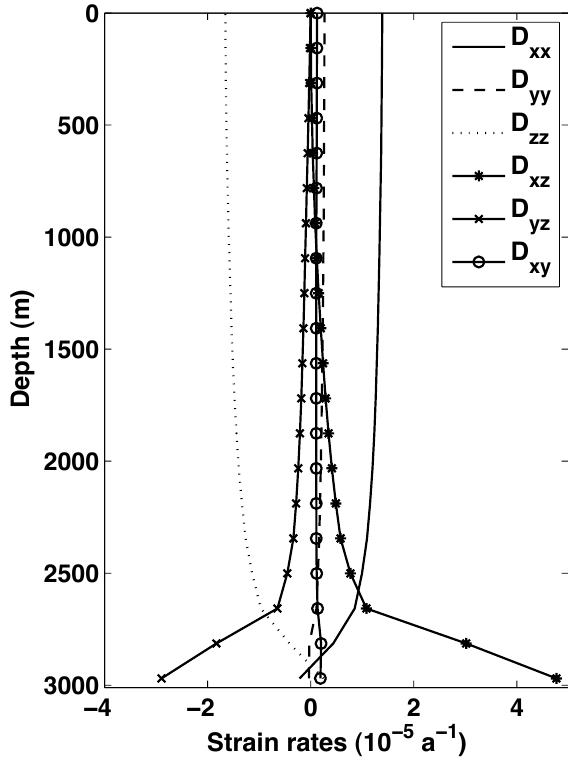
Fig. 7. Anisotropic steady-state simulation: Profiles of the compo- nents D xx , D yy , D zz , D xy , D yz and D xz of the strain-rate tensor D at the Dome Fuji drill